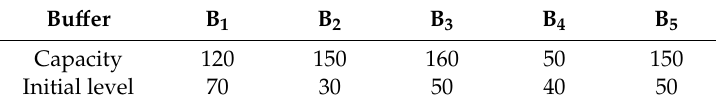
Table 4. Parameters of bu ff ers in a serial manufacturing system.